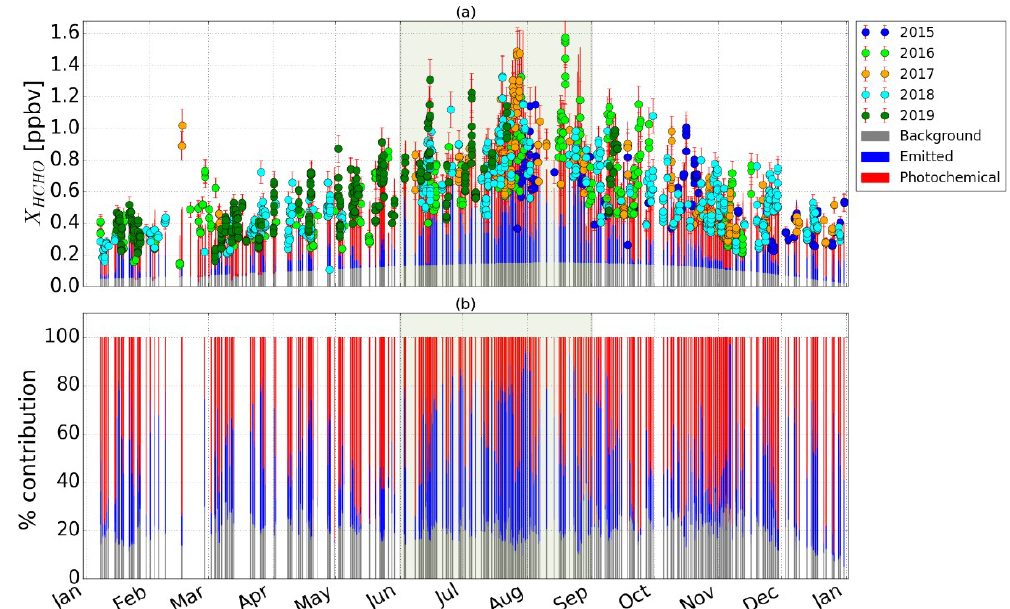
Figure 5. (a) Separation between emitted and photochemical HCHO by using CO–O x tracers to model FTIR observations. (b) Relative contributions of emitted, photochemical and background sources to the observed X HCHO from 2015 to 2019 over Hefei, eastern China. The grey vertical shaded area indicates summertime measurements. Table 4. Statistical modeling results for relative contributions of different sources to the observed X HCHO from 2015 to 2019 over Hefei, eastern China. Items Total Emission Photochemical Background N (%) domination domination domination N (%) N (%) N (%) All 1502 (100%) 480 (31.9%) a 1022 (68.1%) 0 (0) Before 12:00 (LT) 727 (48.4%) 322 (21.4%) 405 (27.0%) 0 (0) After 12:00 (LT) 775 (51.6%) 158 (10.5%) 617 (41.1%) 0 (0) JJA/SON 890 (59.3%) 287 (19.1%) 603 (40.1%) 0 (0) DJF/MAM 612 (40.7%) 193 (12.8%) 419 (27.9%) 0 (0) d% > 0% b 717 (47.7%) 273 (18.2%) 444 (29.6%) 0 (0) d% < 0% 785 (52.3%) 207 (13.8%) 578 (38.5%) 0 (0) Contribution 100% 29.0 ± 19.2% c 49.2 ± 18.5% 21.8 ±